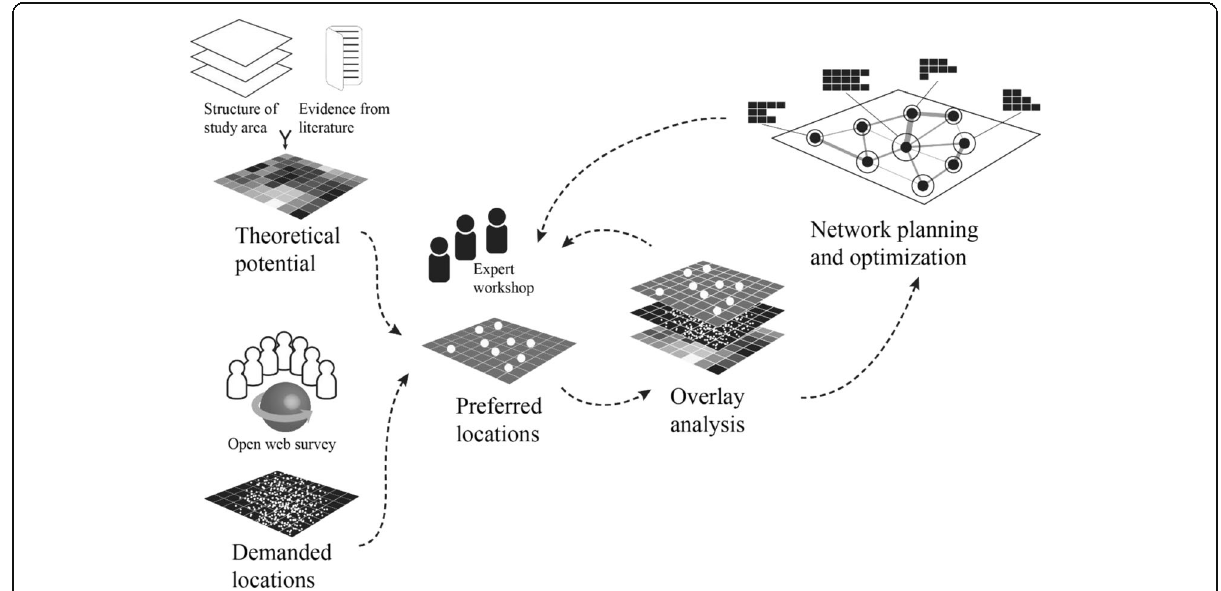
Fig. 1 Spatial framework for planning station-based bike sharing